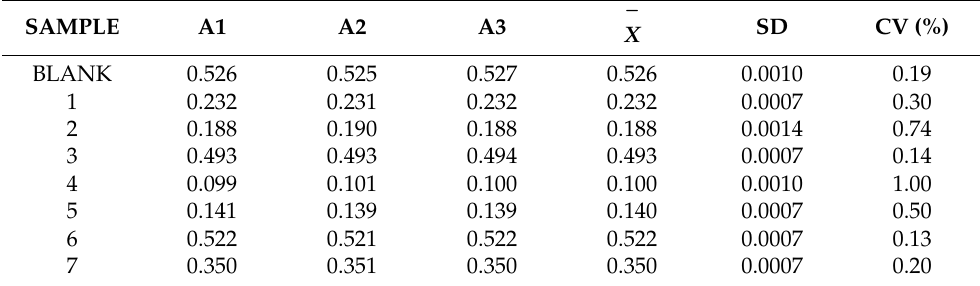
Table 14. Absorbances obtained for lipophilic extracts of cream samples (ABTS method).